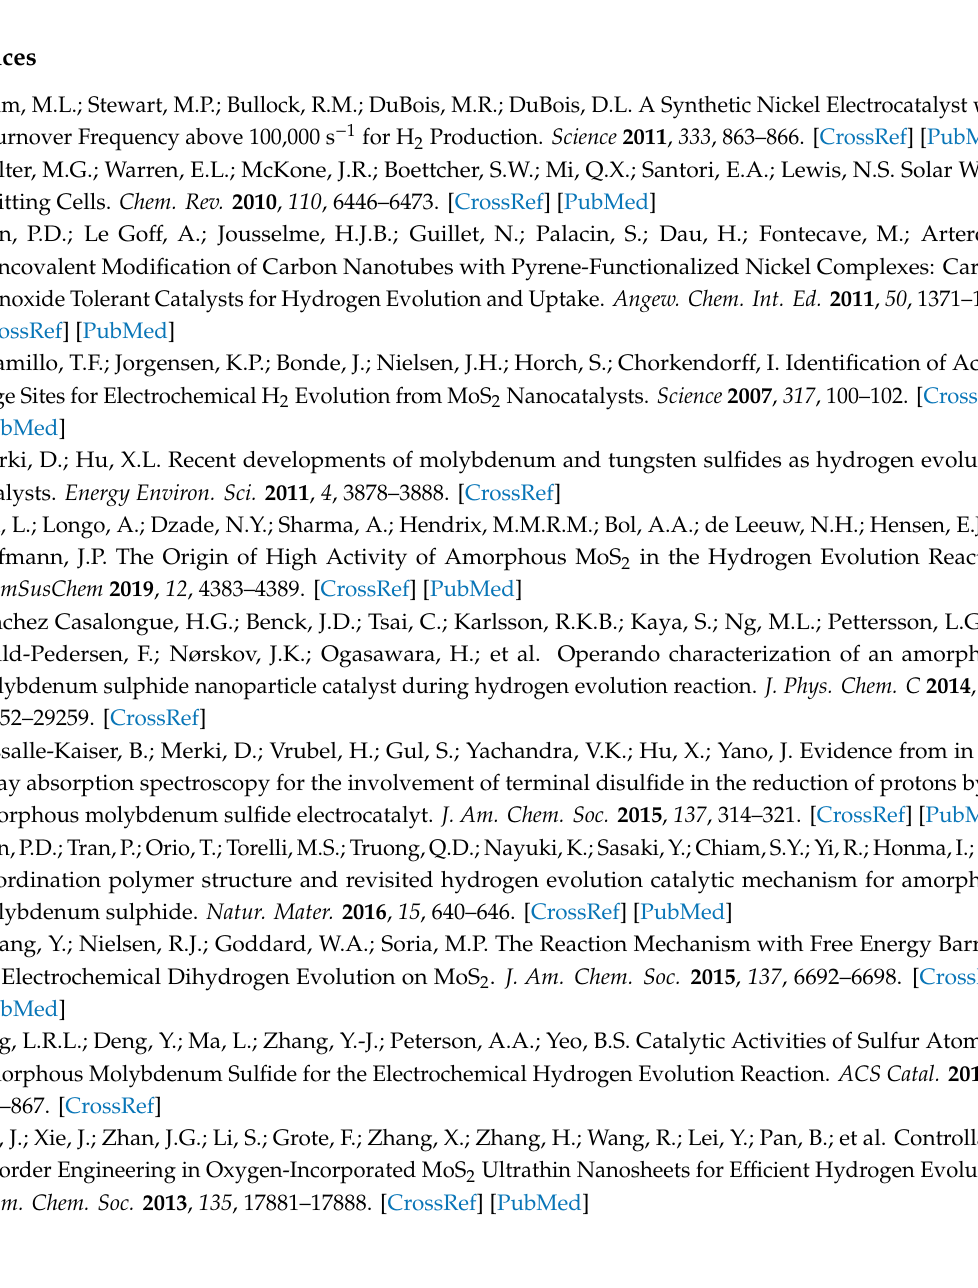
Figure S1: In situ electrochemical cell, Figure S2: Raman spectroscopy and XRD characterization, Figure S3: k 3 weighted experimental data and fit at Mo K edge at di ff erent potentials, Figure S4: S 2p and Mo 3d photoemission lines for the commercial MoS 2 at di ff erent potentials, Tables S1–S3: Structural parameters obtained from fitting the Mo K edge, Table S4: Analysis of the single chemical components of the S 2p and Mo 3d regions at di ff erent